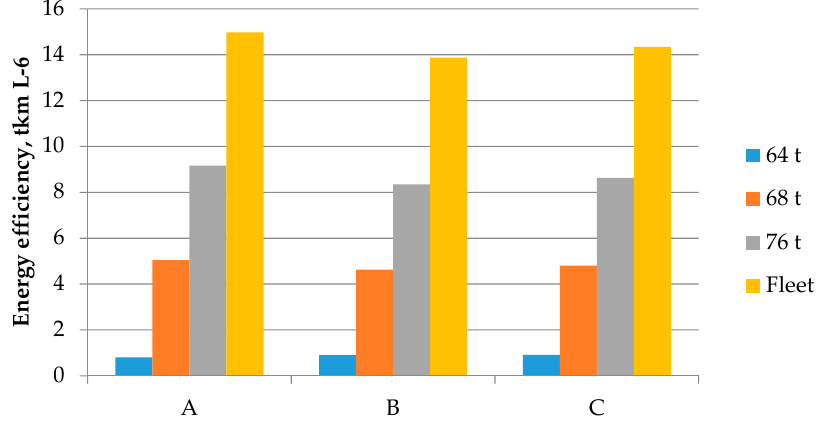
Figure 9. Energy efficiency of the timber transportation fleet (tkm · L − 1 ). The vehicle combinations (64, 68 and 76 t) are managed using TFMC A, B and C for driving on forest roads: A = 40, 4 and 2% for 64, 68 and 76 t vehicles, respectively; B = 15, 15 and 15%, respectively; and C = 5, 5 and 5%, respectively. In 2016, the 64, 68 and 76 t vehicle combinations made 19,800, 70,800 and 121,600 trips, respectively. The transport distance varied from 1 to 441 laden-km, and the operational fuel consumption was about 10628,459 L for measured trips. Due to HCT’s higher timber load capacity, their energy efficiency during timber transportation was 13.4% higher per tkm for measured loads in the entire fleet of the STS. There is also the theoretical potential for a further 3.1% increase in energy efficiency within the STS, if all timber is transported from forest to mill using 76 t vehicles. were 3.5% higher per load’s vehicle-kilometer. The CO 2 emissions of road-transportation vehicles (kg) were calculated for PTC-quantity of the vehicle combination in the STS in the efficient highway network, i.e. in FMO-C.